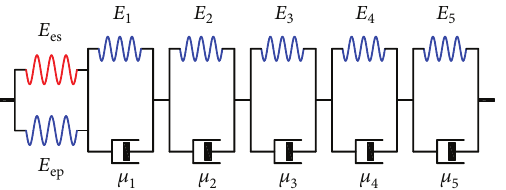
Figure 9: Six-element Kelvin-Voigt viscoelastic model with steel mesh.